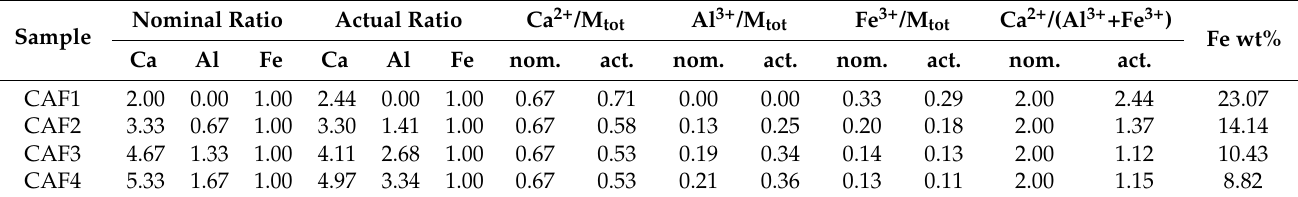
Table 3. Quantitative data on Ca–Al–Fe LDHs. Nominal (nom.) and actual (act.) ratios stand for molar metal ratios in starting solution and the values calculated from ICP-OES, respectively. M tot indicates the total metal contents including Ca, Al, and Fe.